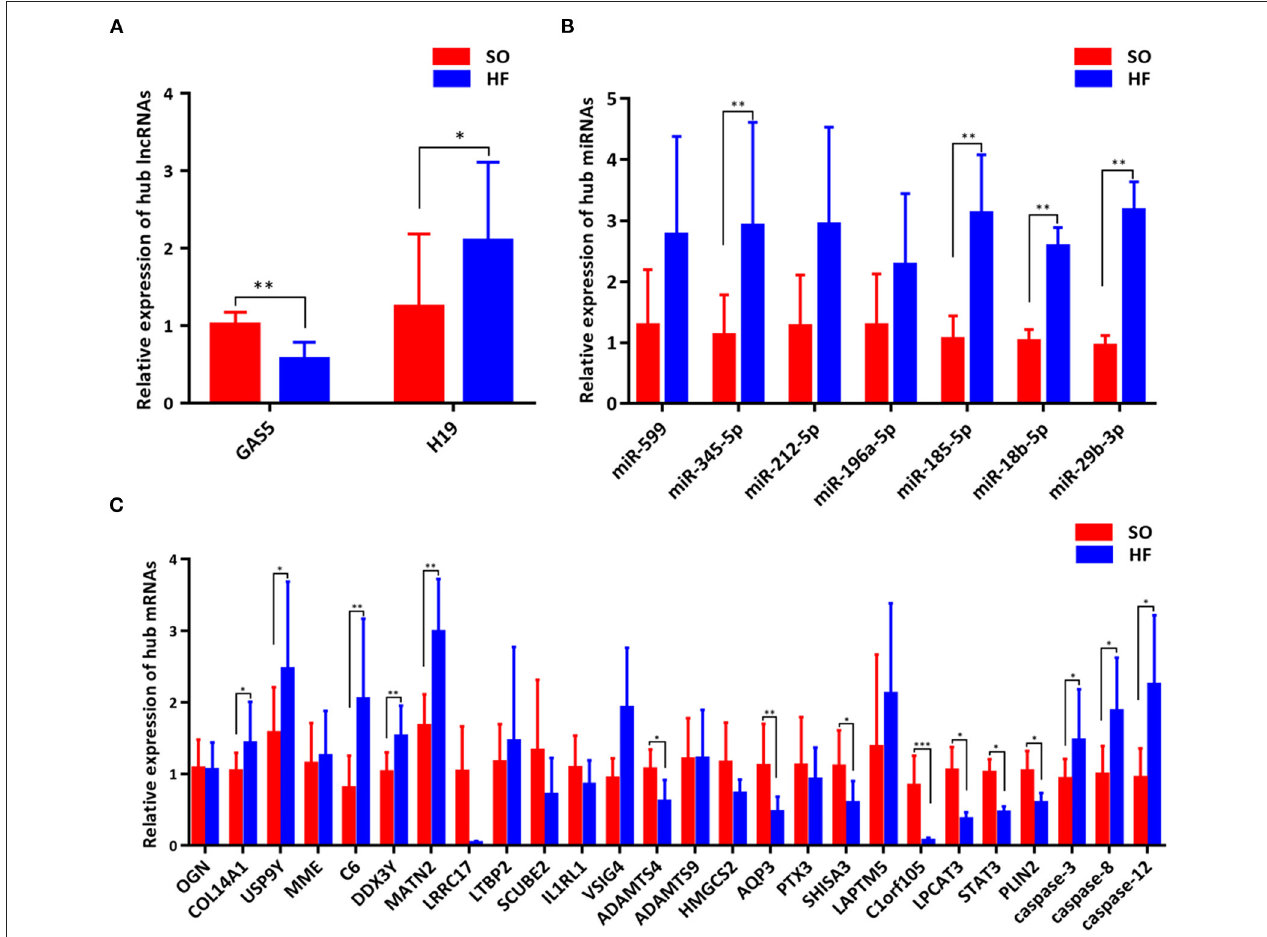
FIGURE 6 | Validation of genes in the programmed cell death regulatory pathways. (A) Expression of hub lncRNAs in ceRNA networks; (B) Expression of hub miRNAs in ceRNA networks; (C) Expression of hub mRNAs in ceRNA networks. * P < 0.05; ** P < 0.01; *** P <